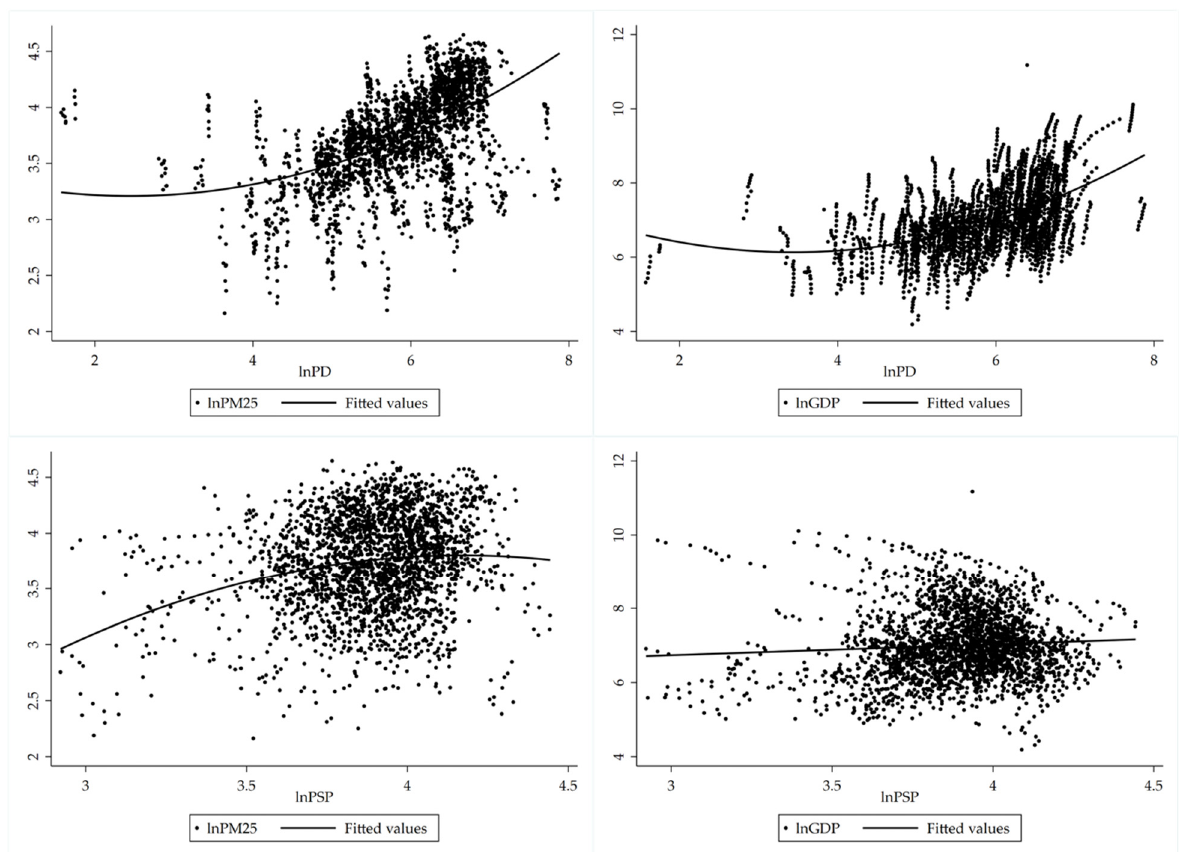
Figure 6. The relationship between PM2.5 concentration and population density and secondary industry.